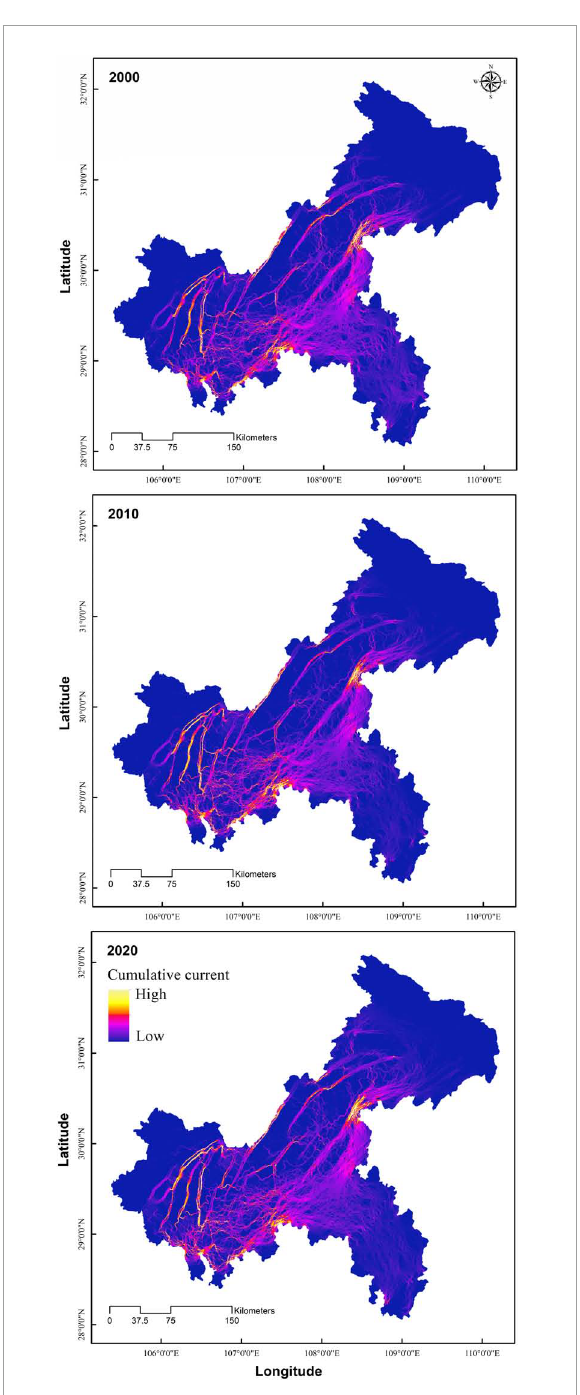
FIGURE5 Spatial distribution of ecological corridors of Chongqing Municipality in 2000, 2010, and 2020.